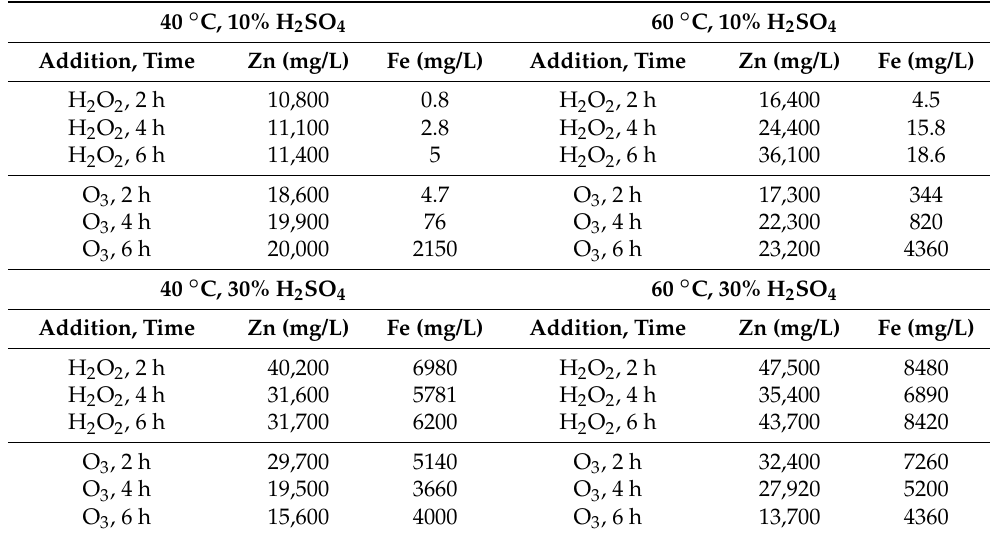
Table 3. Content of zinc and iron in the leach in dependence of concentration and temperature of H 2 SO 4 , time of leaching at addition of H 2 O 2 or O 3 . Sample: H21.